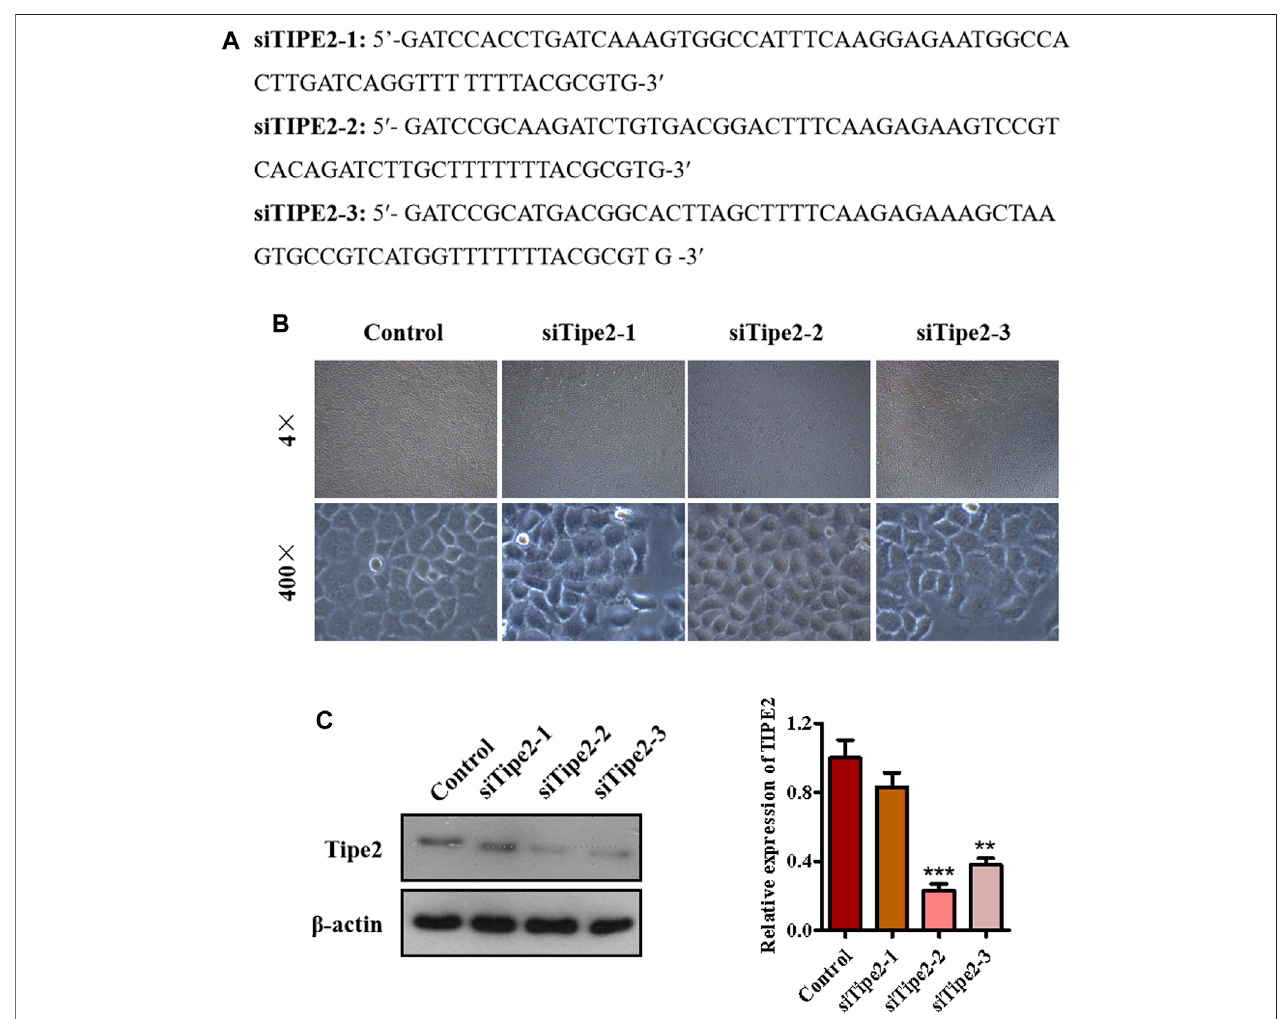
FIGURE 3 | The establishment of TIPE2-silence cell line BGC823/TIPE2 − / − . (A) The sequence of siTIPE2 RNA. (B) The effect of siTIPE2 RNA on BGC-823 cells. (C) The effect of siTIPE2 RNA on TIPE2 expression. The values of the histogram are displayed as mean ± SD, 0.001 < p < 0.01 (**) represented for very signi fi cant difference and p < 0.001 (***) represents an extremely signi fi cant difference to the normal control.